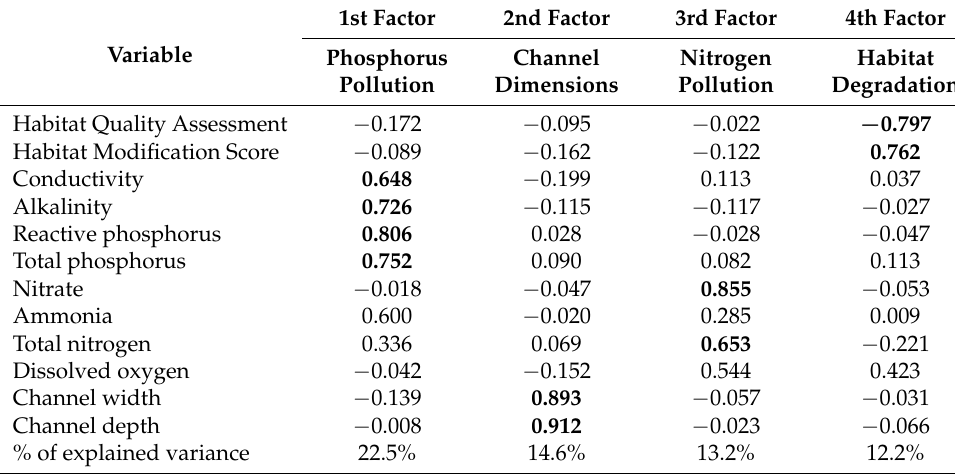
Table 4. Factor analysis results for 16 environmental variables.